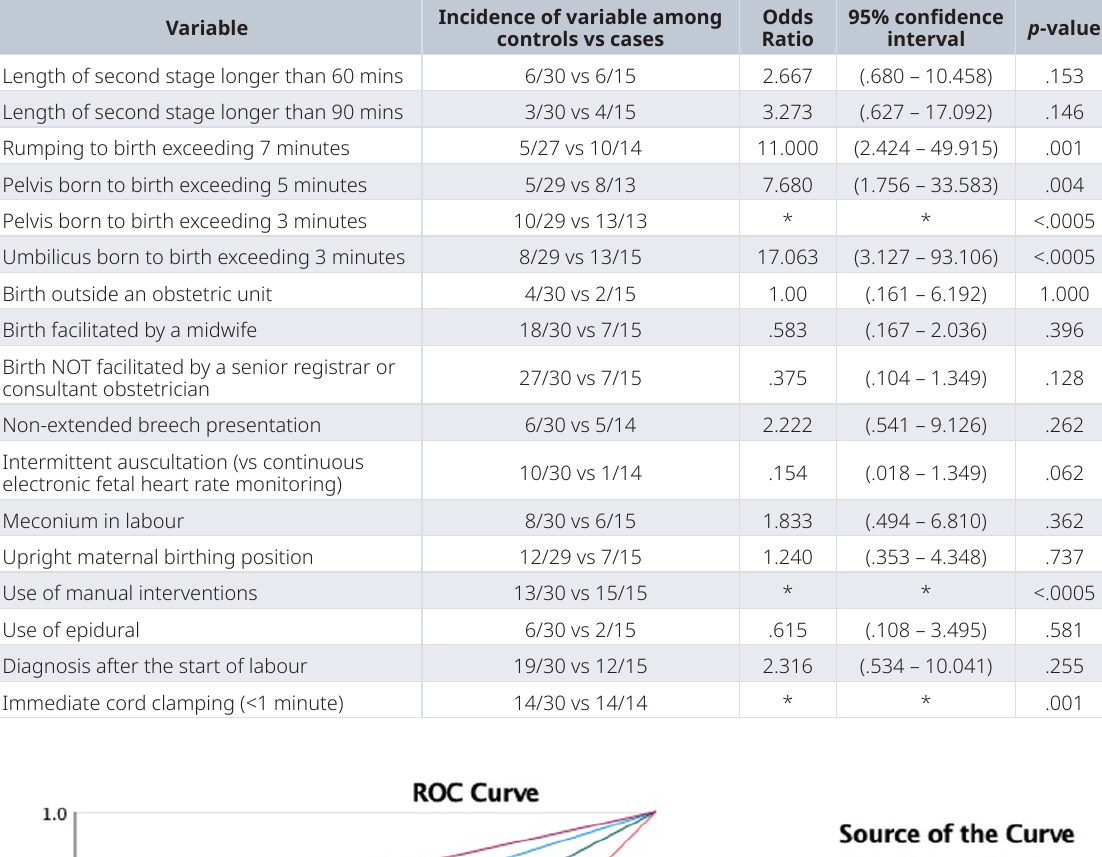
Table 1. Association of intrapartum risk factors with primary outcome (NICU admission or death). P-values calculated with chi-square or Fisher’s exact test